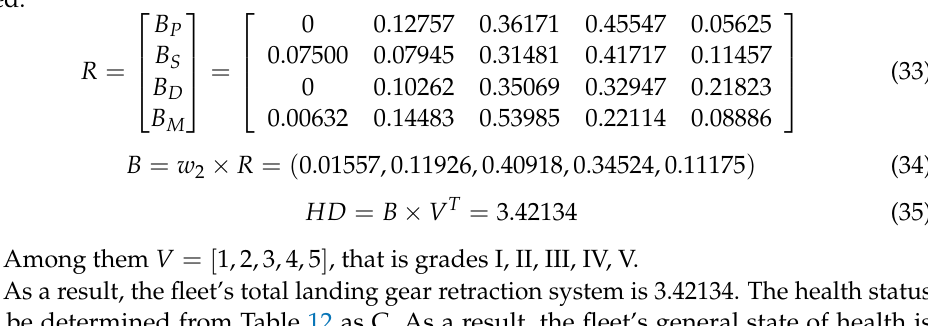
Statistical table of detection difficulty; Table S2: Statistical table of maintenance difficulty; Table S3: Simulation of case data